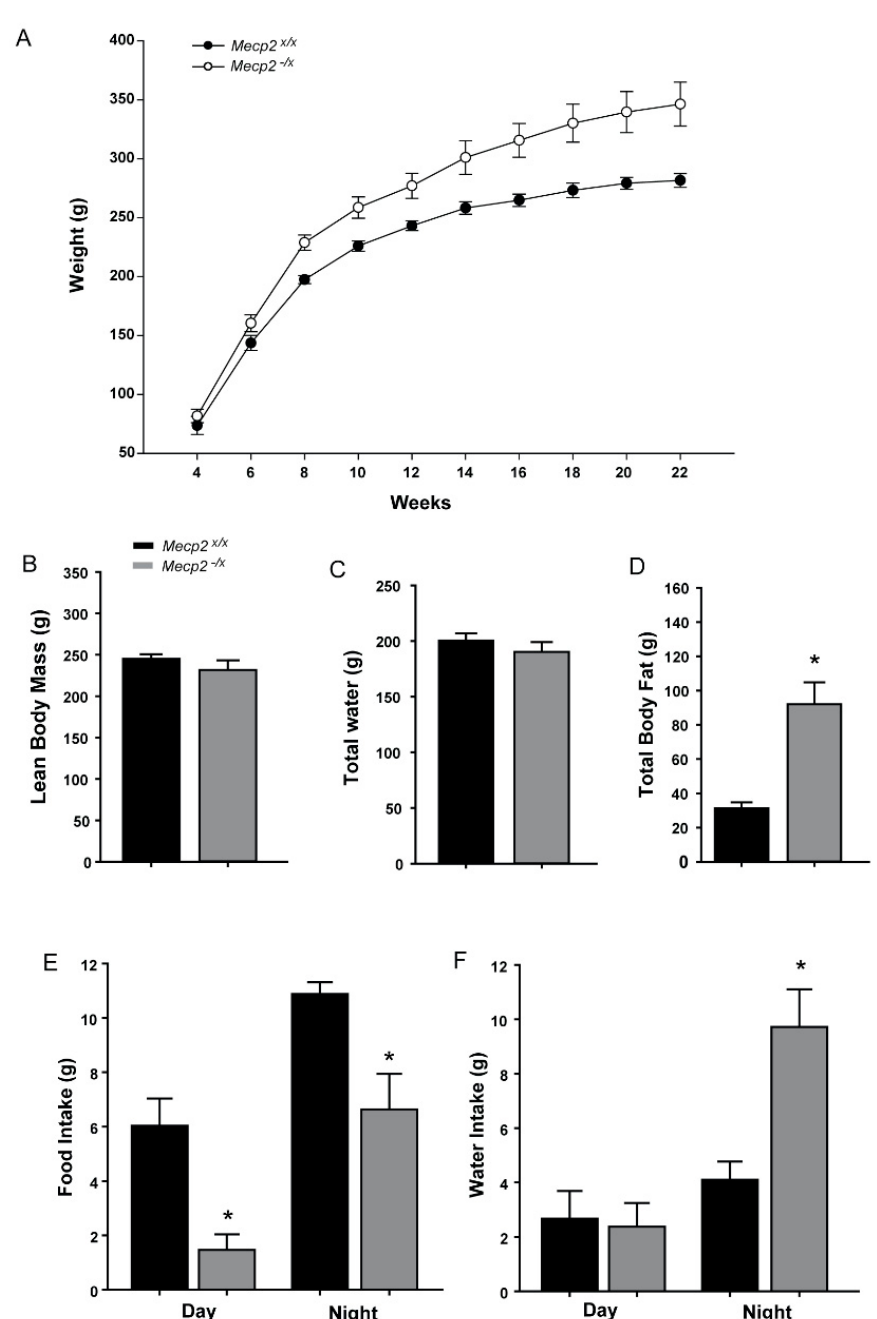
Figure 4. Abnormal weight gain and calorie intake in the RTT rat model. ( A ) Biweekly weight measurements from Mecp2 x/x and Mecp2 − /x rats reveal a significantly increased body weight starting from eight weeks of age ( p < 0.001, two-way repeated measure ANOVA with Holmes-Sidak posthoc analysis; see Table 1 for statistical details); ( B – D ) Comparison of body mass composition between Mecp2 x/x and Mecp2 − /x rats by Echo-MRI analysis. No difference in lean body mass ( B ) or total water content ( C ) detected between the two groups. Body fat levels were highly elevated in the Mecp2 − /x ; ( D ) p = 0.0001; ( E ) Food intake comparison between the two groups revealed lower consumption by the Mecp2 − /x rat both during day ( p = 0.001) and night ( p = 0.044) ( t -tests); ( F ) Water intake compared between the two groups of rats. No diurnal difference, but nocturnal consumption is highly increased in Mecp2 − /x rats ( p = 0.016, t -test. n : WT = 5, Mecp2 − /x = 10). All graphs represent Mean ± SEM.